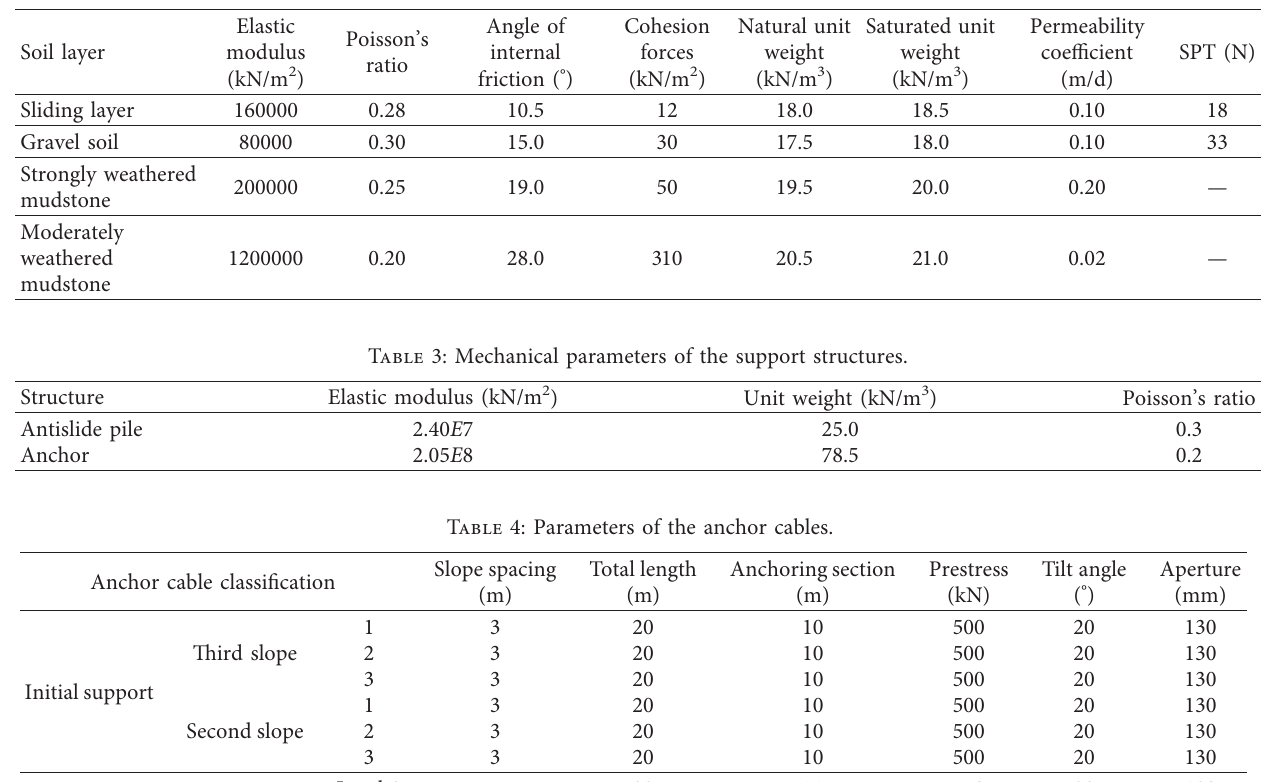
Table 2: Rock and soil parameters.